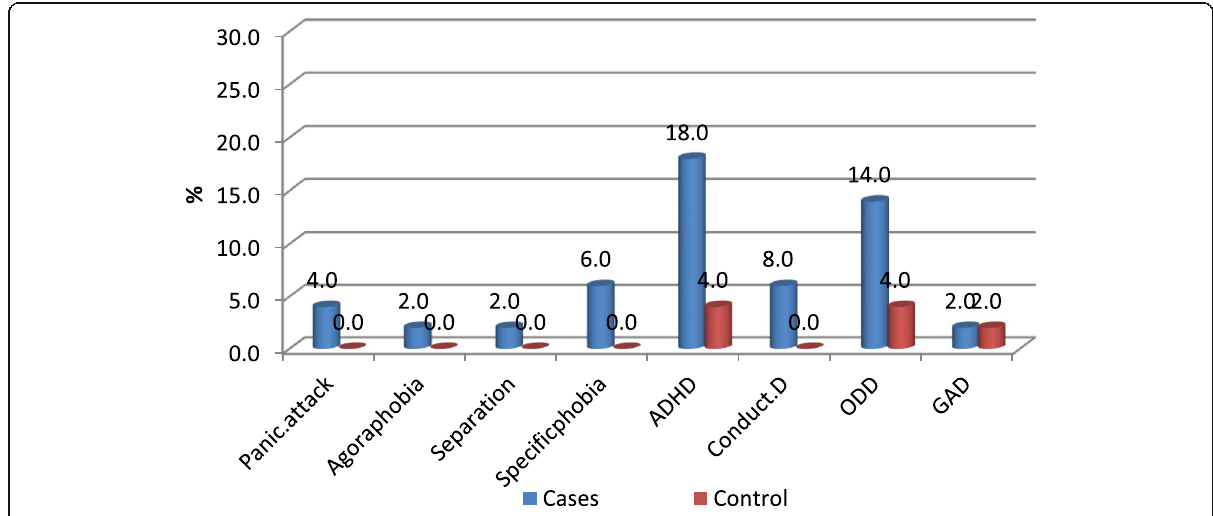
Fig. 1 Frequency distribution of different psychiatric disorders among dyslexic and control groups according to MINI Kid Scale